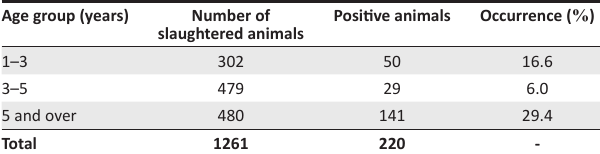
TABLE 2: Occurrence of foreign bodies according to age